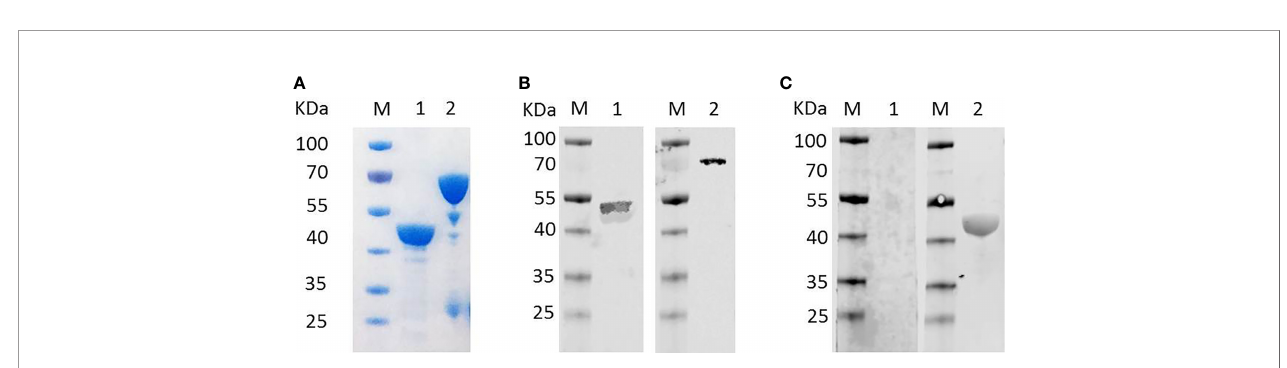
FIGURE 2 | Detection of recombinant Bm Trx-like protein ( Bm TLP). (A) Recombinant Bm TLP were detected by SDS-PAGE and Coomassie brilliant blue staining. Lane 1, His-tagged r Bm TLP; Lane 2, GST-tagged r Bm TLP. (B) His-tagged (lane 1) and GST-tagged (lane 2) recombinant Bm TLP were detected by western blot with monoclonal antibodies against His-tag (Lane 1) or GST-tag (Lane 2) respectively. (C) His-tagged recombinant Bm TLP were detected by western blot with a mixture of serum samples (equal volumes) from seven normal mice (Lane 1) or seven B. microti -infected BALB/c mice 21-day post-infection (Lane 2). Lane M, standard protein molecular weight